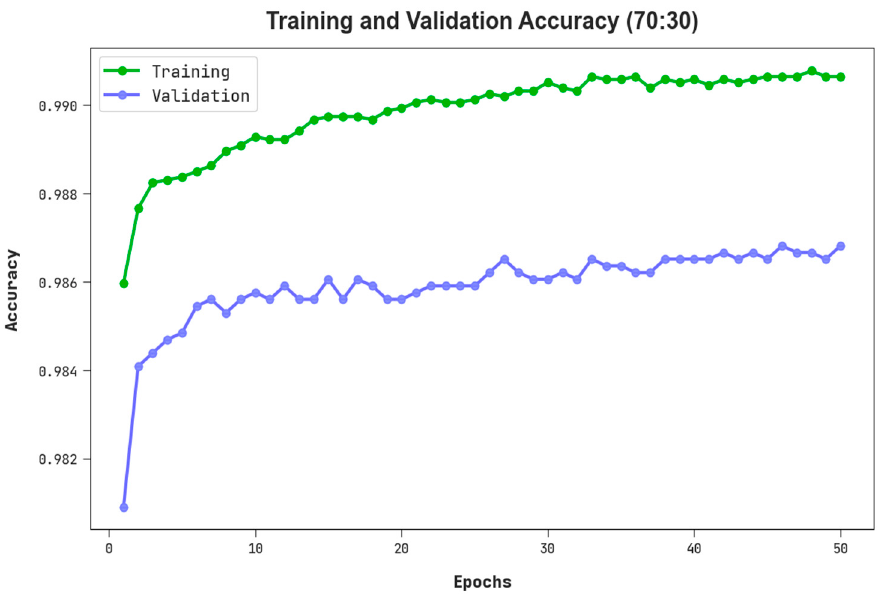
Figure 7. TACC and VACC outcome of RHSODL-AMD system on 70:30 of TRS/TSS. The TLS and VLS of the RHSODL-AMD approach on 70:30 of TRS/TSS are exhibited